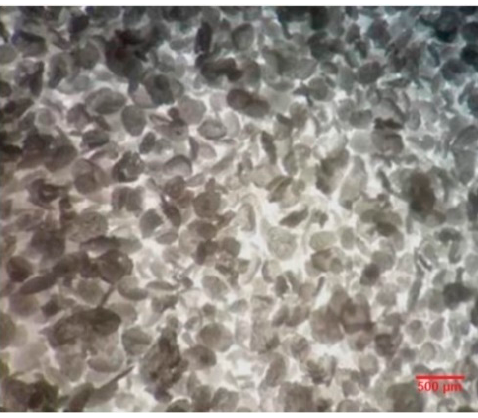
Figure 4. Sample taken during microcapsule synthesis process (optical image, 25× zoom).